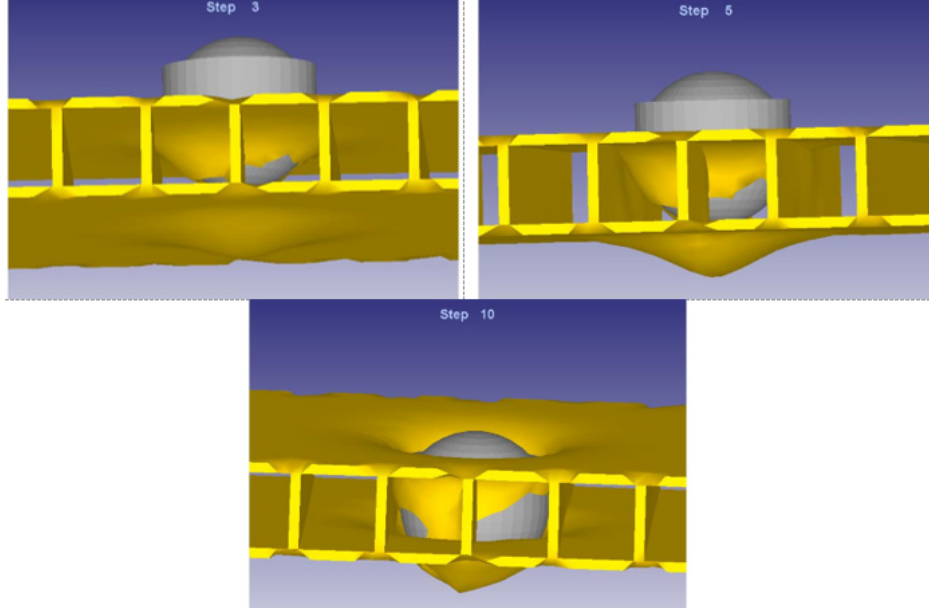
Figure 6 . Impactor head action .